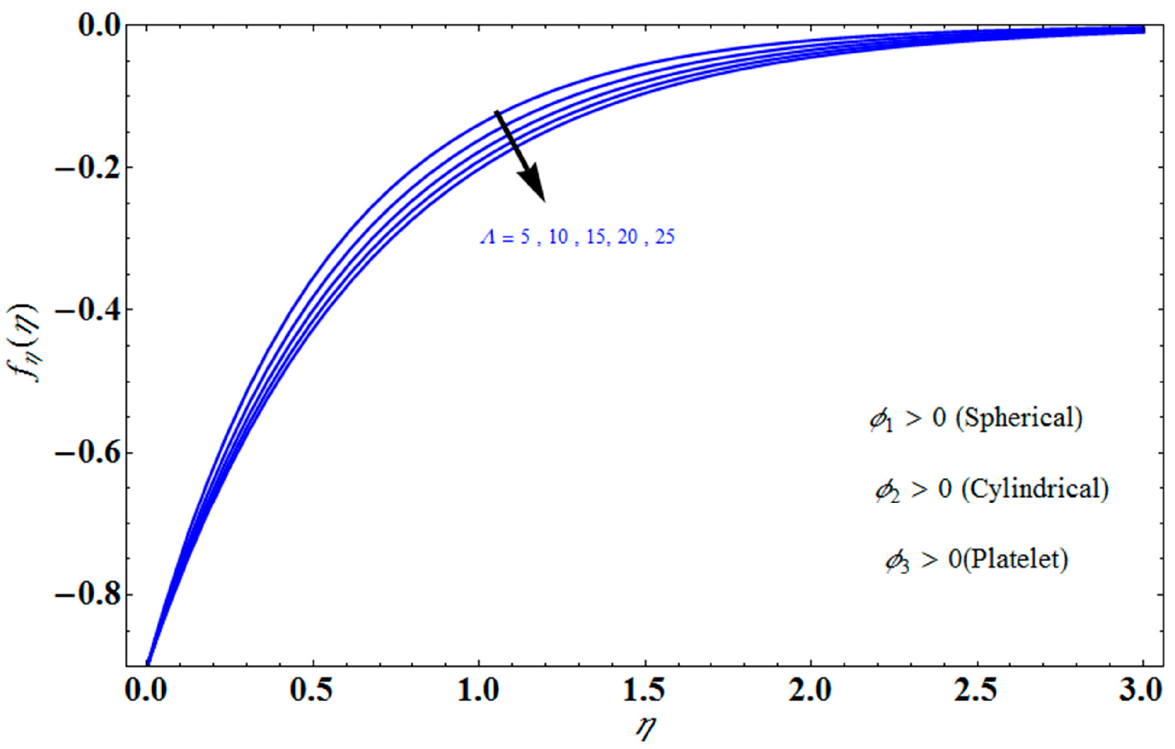
Figure 7. Influence of